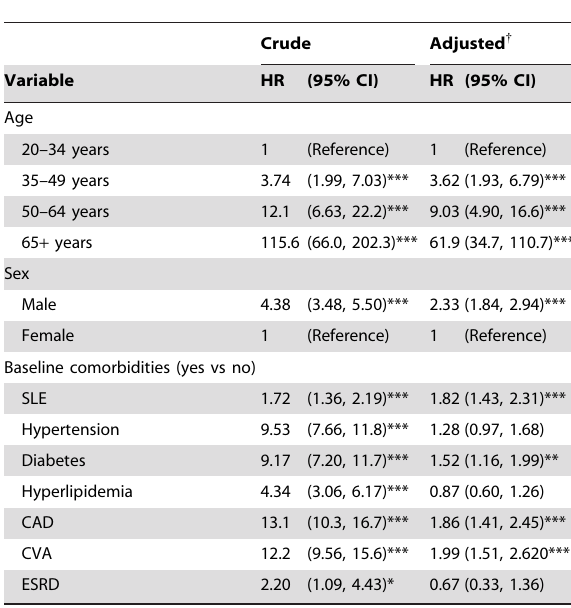
Table 3. Cox model with hazard ratios and 95% confidence intervals of COPD associated with systemic lupus erythematosus and